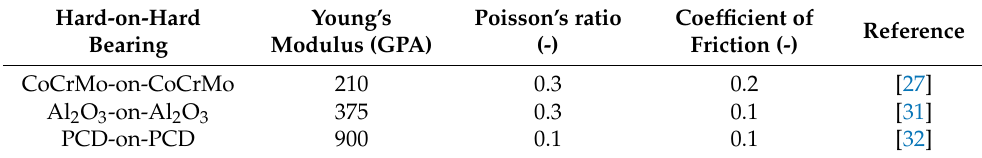
Table 2. Young’s modulus, Poisson’s ratio, and coefficient of friction from hard-on-hard bearings. Hard-on-Hard